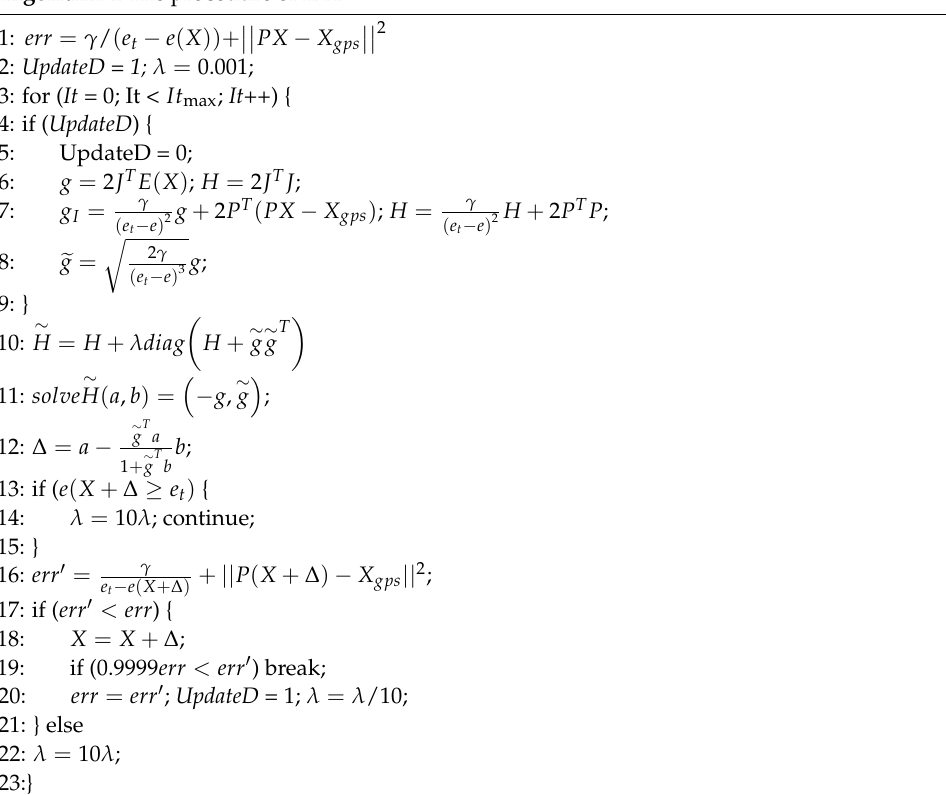
Algorithm 1 The procedure of